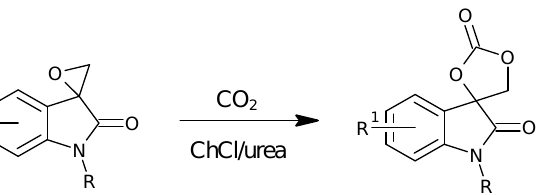
Figure 5. Structure of DES obtained from choline chloride and NBS in a molar ratio of 1:2. R 1 = CH 3 , CH 3 O, F; R = CH 3 , C 4 H 9 , CH 2 =CHCH 2 .